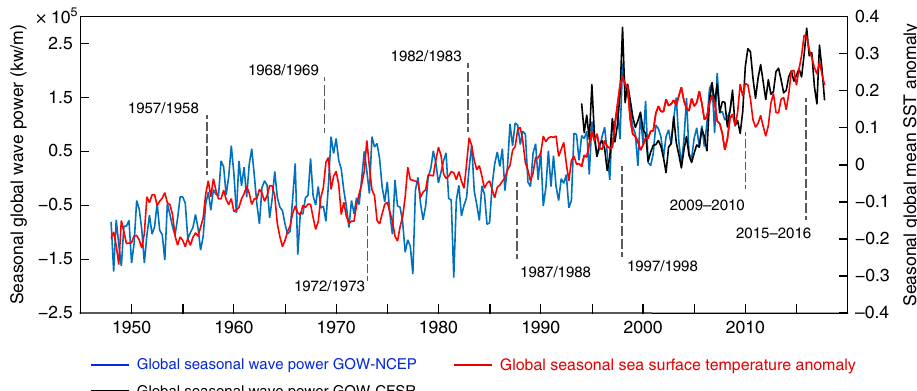
Fig. 3 Historical seasonal variability in oceanographic forcing Global variability in the seasonal Global Wave Power (blue: GOW-NCEP; black: GOW-CFSR; left vertical axis) and Sea Surface Temperature anomalies (red line; right vertical axis). Years corresponding to strong El Niño events, that is, ones with an Oceanic Niño Index value exceeding 1.5, are annotated and overlaid on the